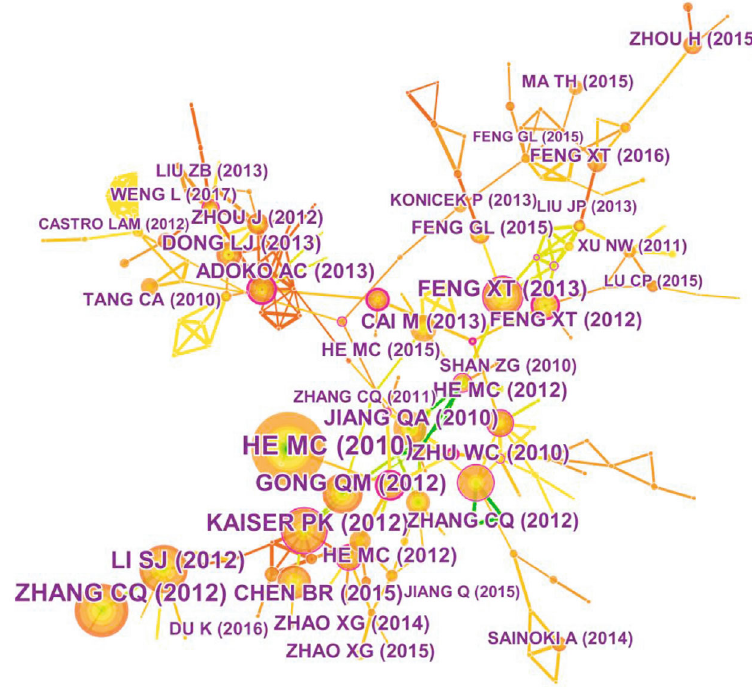
Figure 11: Reference cocitation network. Table 2: Top 10 cited articles of rockburst research in hard